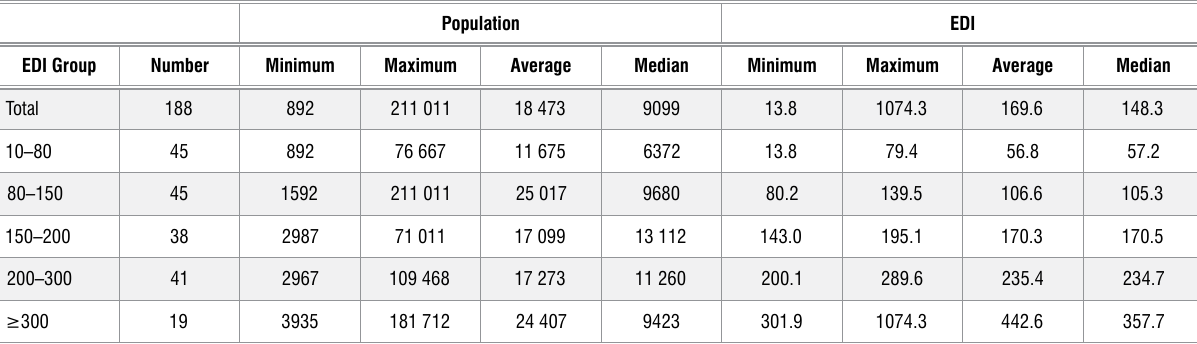
The population and Enterprise Dependency Index (EDI) characteristics of the selected groups of towns population